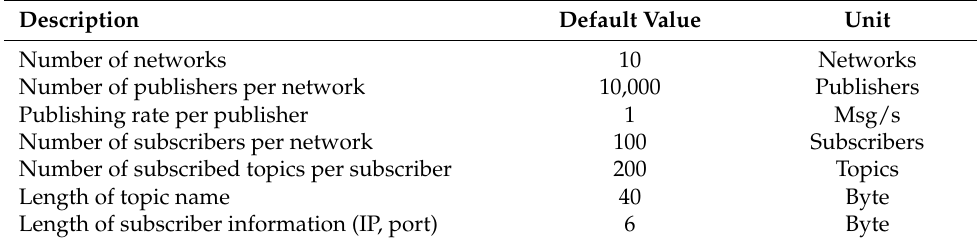
Table 2. Simulation parameters for distributed MQTT